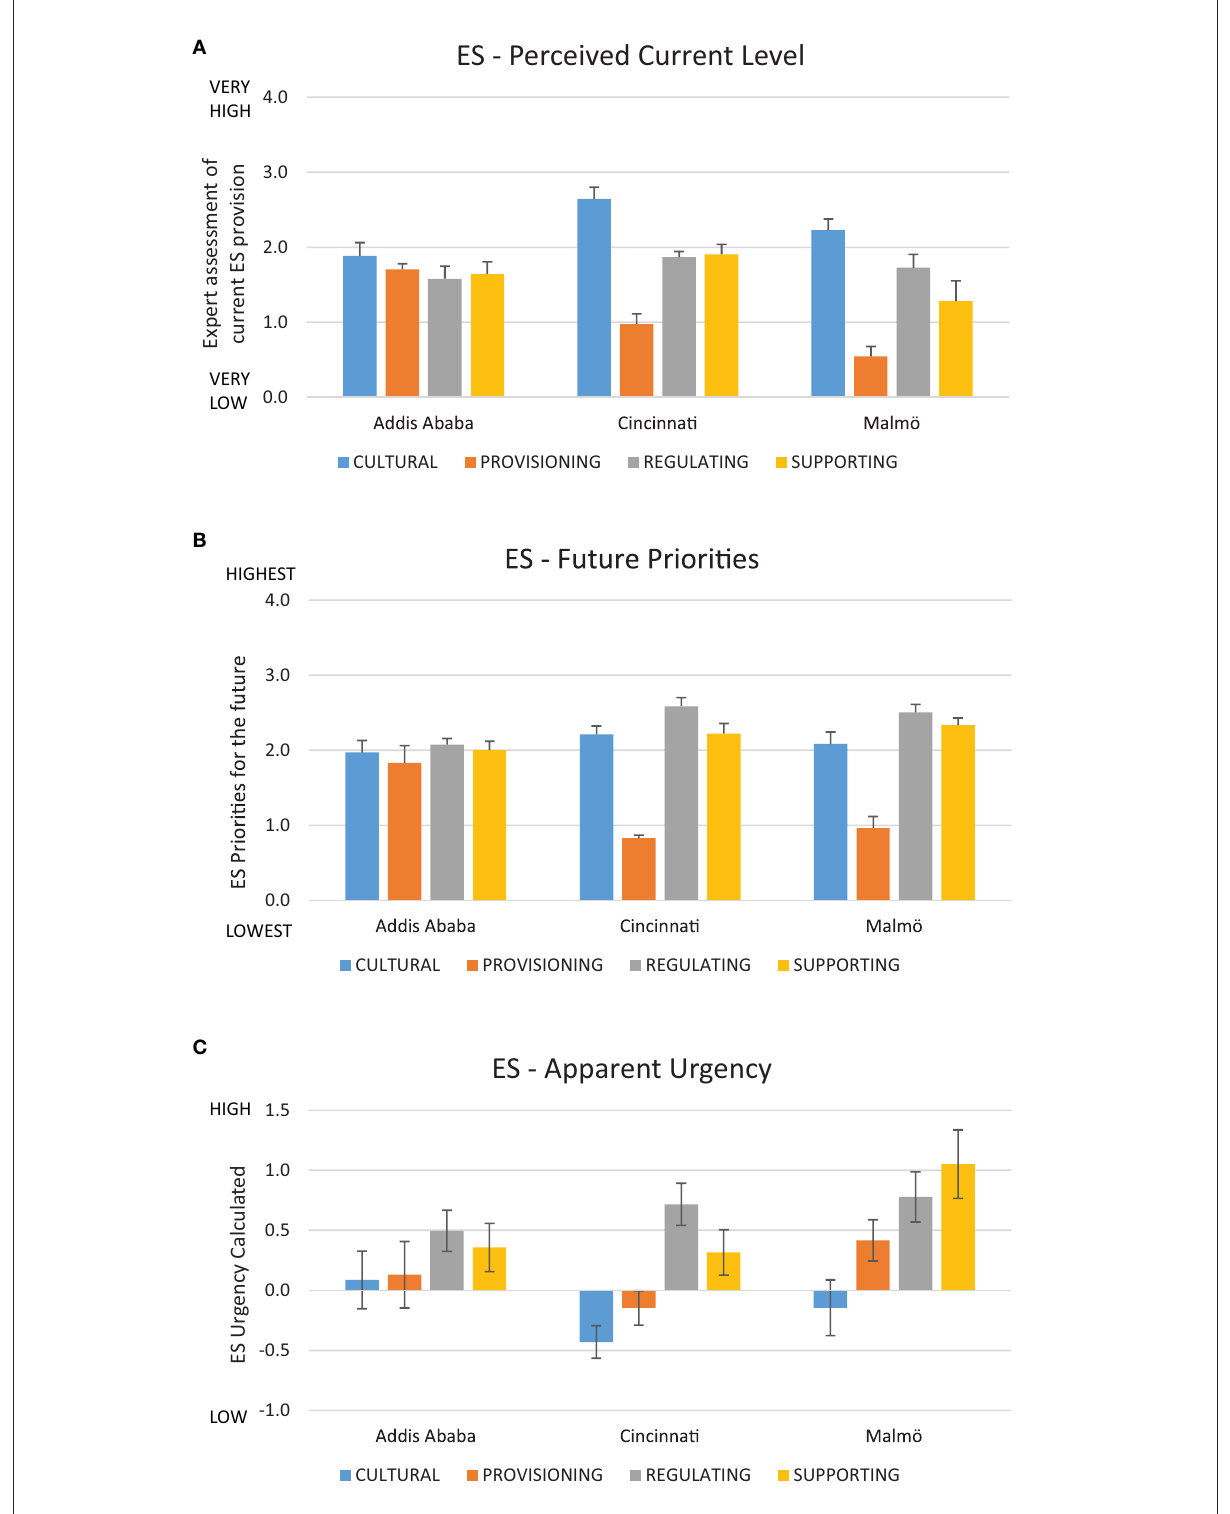
FIGURE2 Expert stakeholder assessments of ecosystem services (ES) provided by urban green infrastructure in the three study cities, grouped by ES category. (A) Current ES provision; (B) highest priorities for the future; (C) Calculation of apparent urgency as the normalized difference between ES priority and current perceived provision. Values given are the average expert stakeholder rating for ES in the given category, with error bars indicating the standard error of the mean. High positive values correspond to high perceived provision, priority, or urgency, respectively.